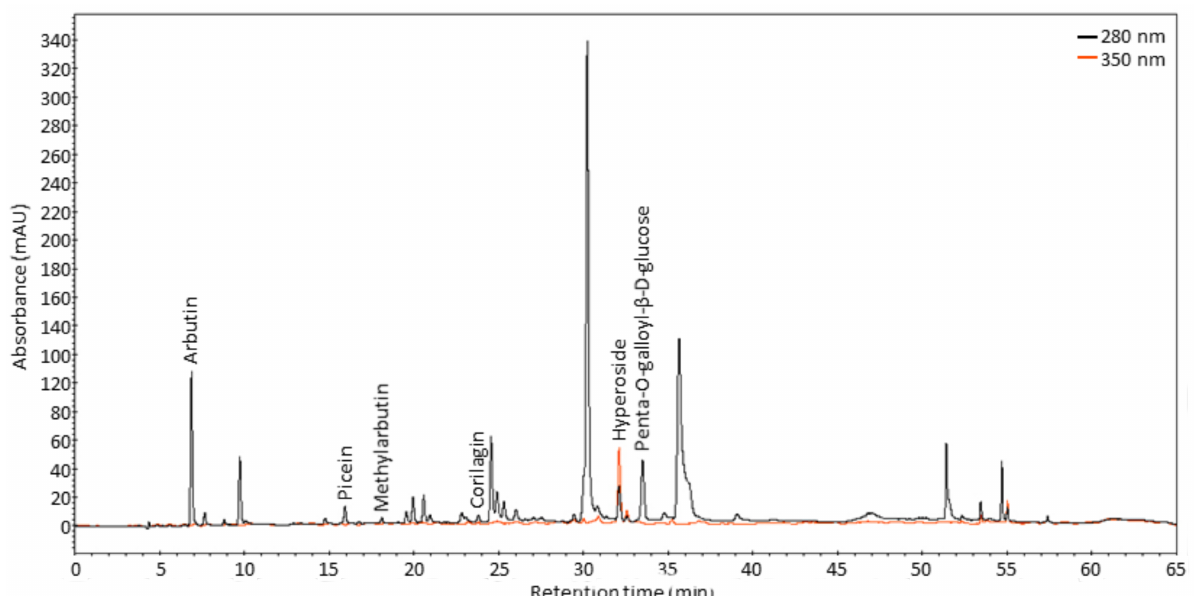
Figure 2. HPLC chromatograms of bearberry ethanolic extract at 280 nm (black line) and 350 nm (orange line). The analysis of extracts from the bearberry leaves showed a wide phytochemical variation in the arbutin (ARB) content, i.e., from 56.32 mg g − 1 to 95.55 mg g − 1 in samples collected in the heathlands and from 68.33 mg g − 1 to 97.26 mg g − 1 in the case of samples collected in the pine forests (Figure 3). There are differences in the mean values of this substance between the samples collected in the heathland, the samples from the pine forest, and between samples from both plant communities (ANOVA, F = 510.3, p < 0.01, Figure 3).